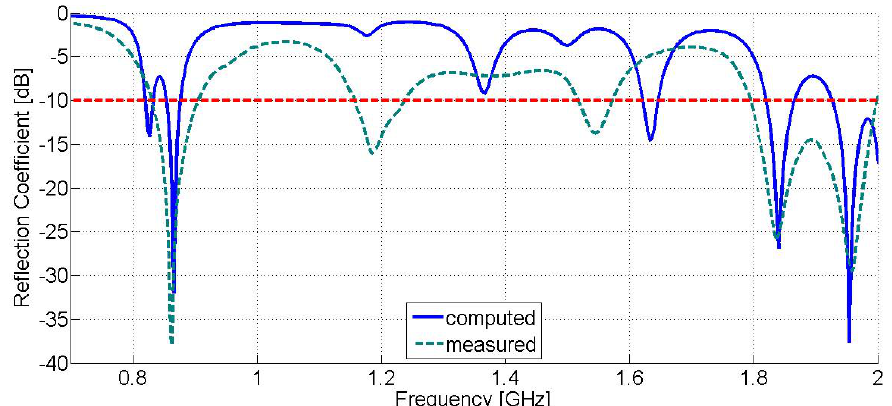
Figure 9. Reflection coefficient ( S 11 magnitude) versus frequency of the proposed RF-to-DC rectifier at a reference level of RF input power equal to 0 dBm (Computed results are displayed in blue solid line, whereas measured results are displayed in dark green dash line. The red dash line represents the − 10 dB